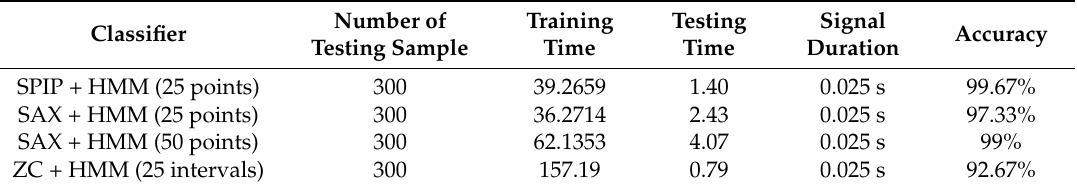
Table 8. Performance of two similar feature extraction